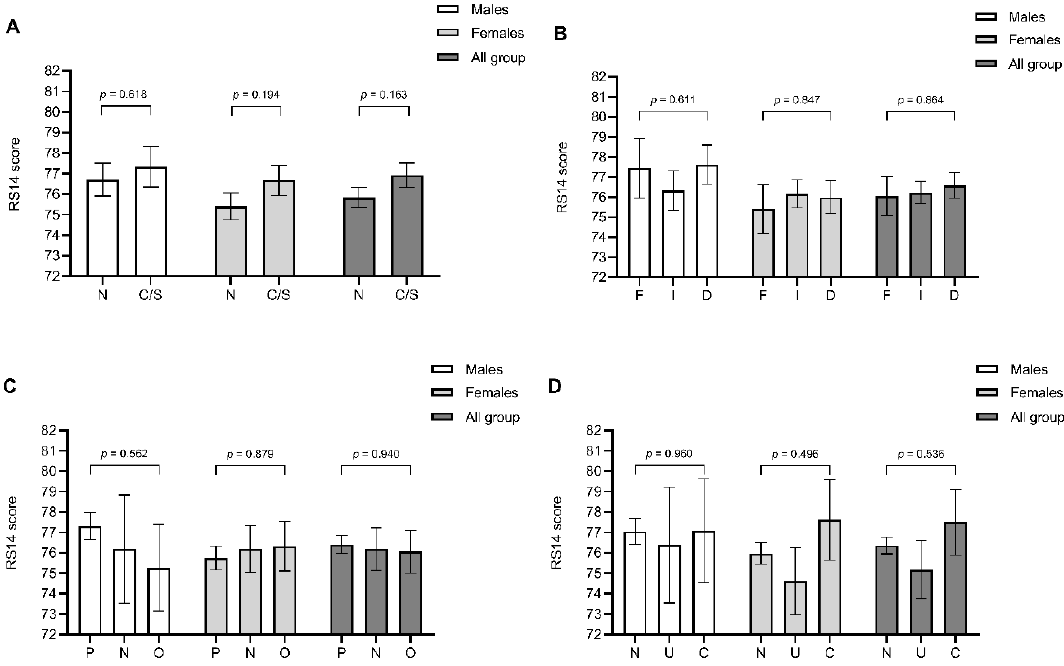
Figure 1. Resilience ( A ), depression ( B , D ), and anxiety ( C ) in healthcare professional (HCP) compared to control group. Data are expressed as mean and standard error of the mean and are stratified according to gender. RS14: 14-item Resilience Scale; BDI-II: Beck Depression Inventory-II scale; HADS-A: Hospital Anxiety and Depression Scale-Anxiety; HADS-D: Hospital Anxiety and Depression Scale-Depression.